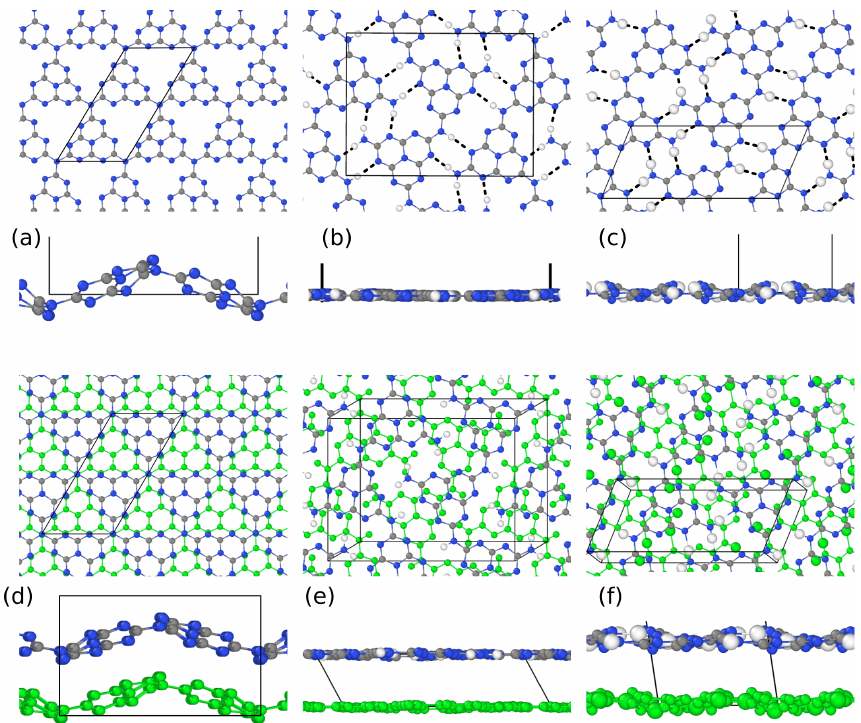
Figure 1. Top and left side views (with different scale) of optimized structures of different gCN models: ( a , d ) igCN, ( b , e ) melon alternated, ( c , f ) melon linear. Top panels report 2D structures; lower panels, corresponding bulk geometries. The unit cell structure is shown with black lines. Blue, gray, and white spheres represent N, C, and H atoms, respectively. For bulk systems, the second layer included in the supercell is shown through green spheres. For the melon models, the H-bonds are reported only in the 2D case with dashed